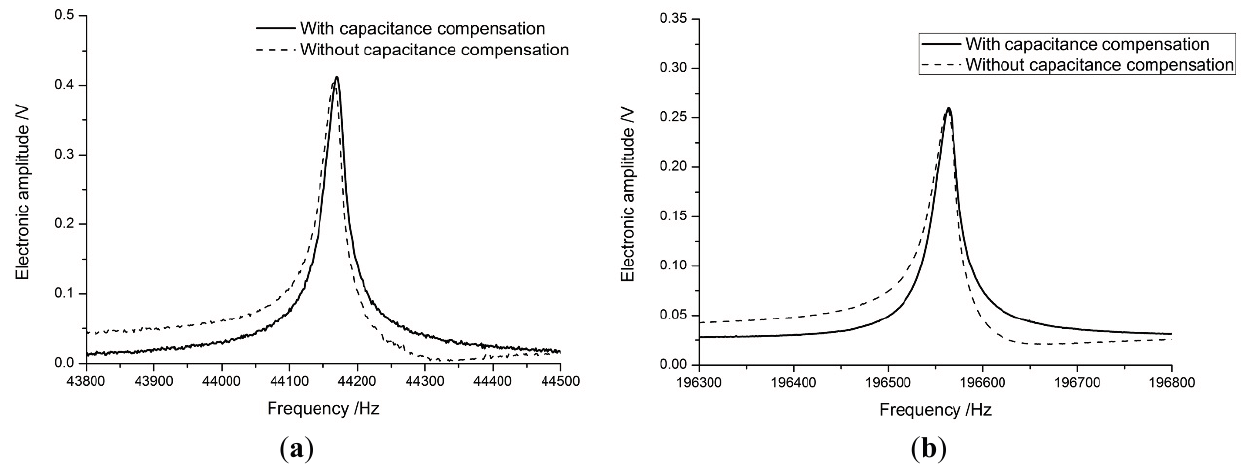
Figure 7. The electrical amplitude-frequency response of an Akiyama probe. ( a ) The first eigenmode; ( b ) The second eigenmode.